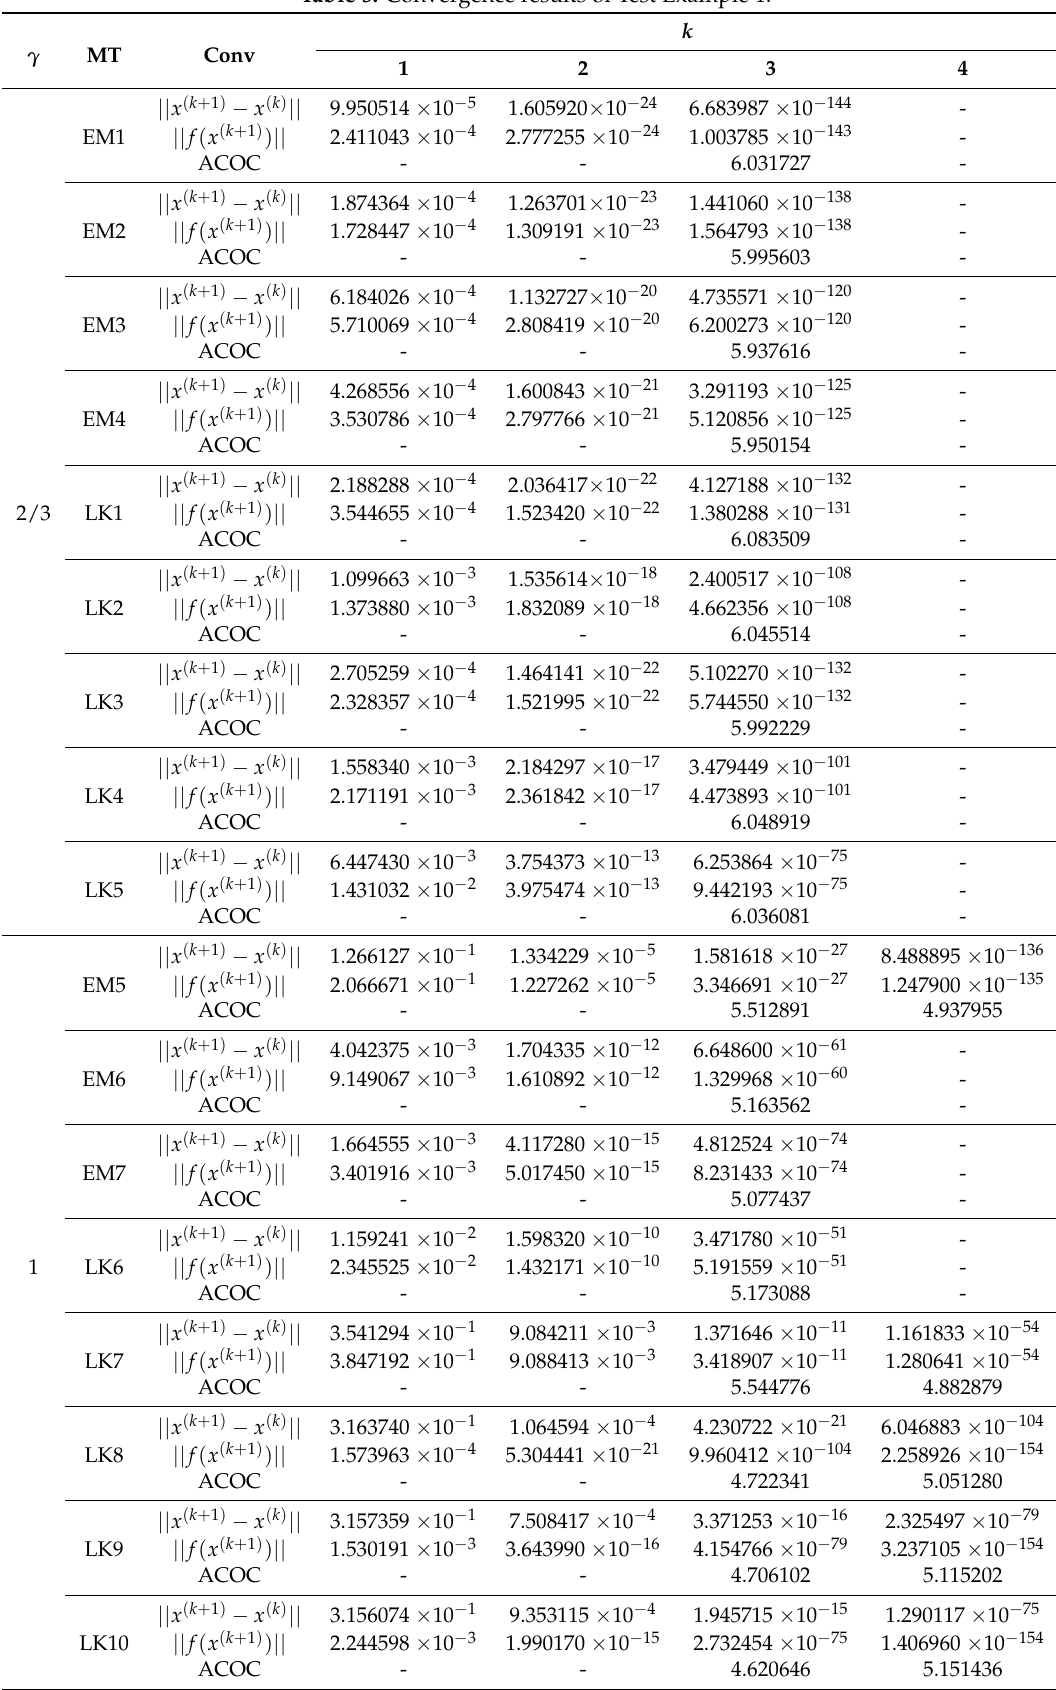
Table 5. Convergence results of Test Example